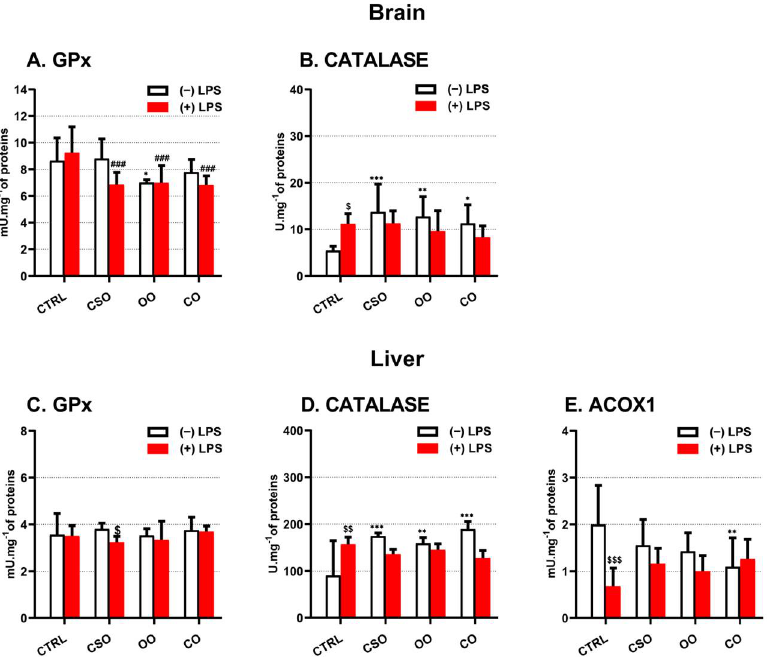
Figure 8. Effect of cactus seed oil, olive oil, or colza oil treatment on the peroxisomal enzymes activities of brain and liver GPx ( A , C ) and CAT ( B , D ), respectively, and on liver ACOX1 ( E ). C57BL/6 mice received for 28 days a standard diet (control (CTRL)), a diet enriched with 6% ( w / w ) CSO, OO, or CO, and intravenous injection of LPS (100 µ g) four hours antemortem. Brain and liver homogenates were prepared as described in Material and methods section. Results are expressed in (UI.mg − 1 = one µmol of substrate transformed/minute/mg of proteins). All values are means ± SD (n = 6), statistical significance of higher mean signal strength (*** p ≤ 0.001. ** p ≤ 0.01. * p ≤ 0.05) compared to control, (### p ≤ 0.01) compared to LPS, and ($$$ p ≤ 0.001 and $$ p ≤ 0.01, $ p ≤ 0.05) compared to the different treatments with or without LPS administration. Statistics were executed using two-way ANOVA followed by Tukey test for multiple comparisons.